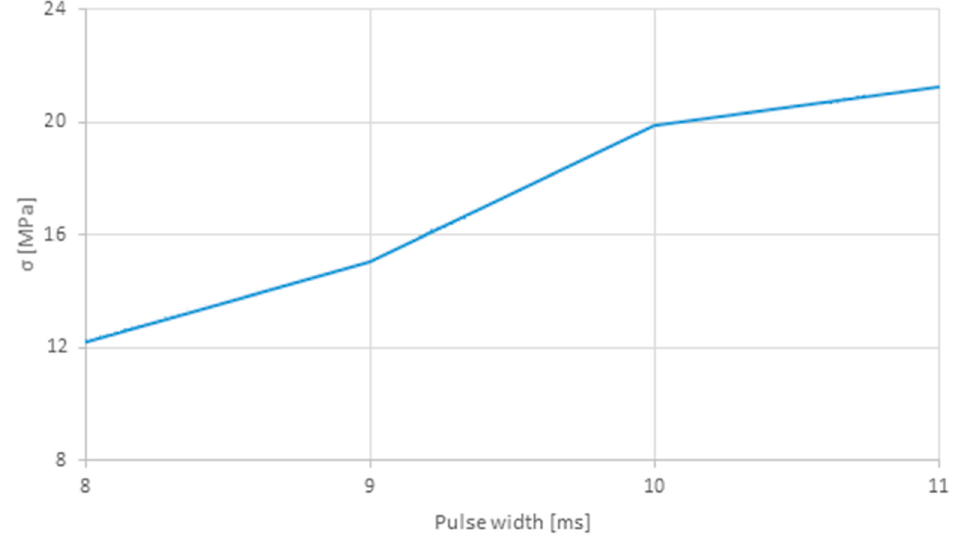
Figure 6. Tensile strength obtained for different square pulse widths (sets 1–5).